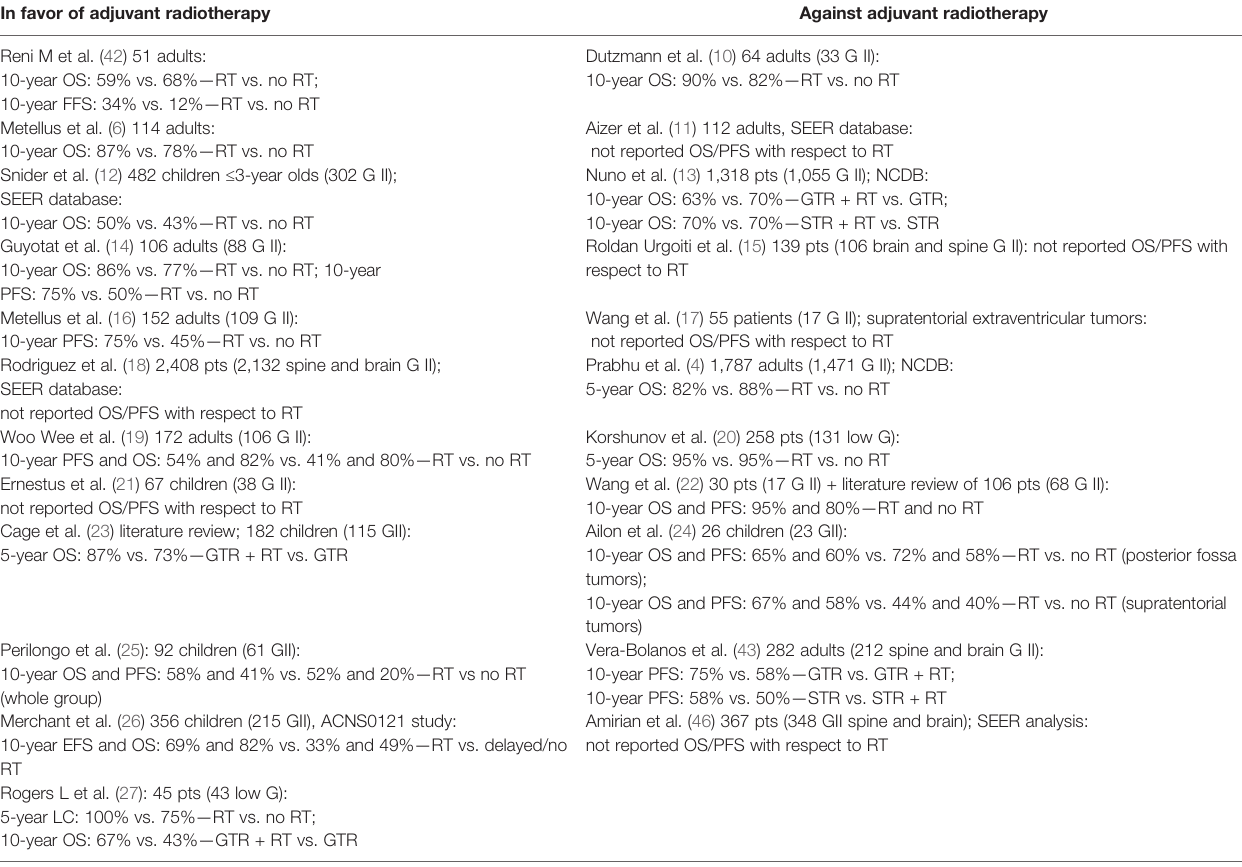
TABLE 4 | Studies of patients with cranial grade II ependymomas with regard on the impact of adjuvant radiotherapy. In favor of adjuvant radiotherapy Against adjuvant